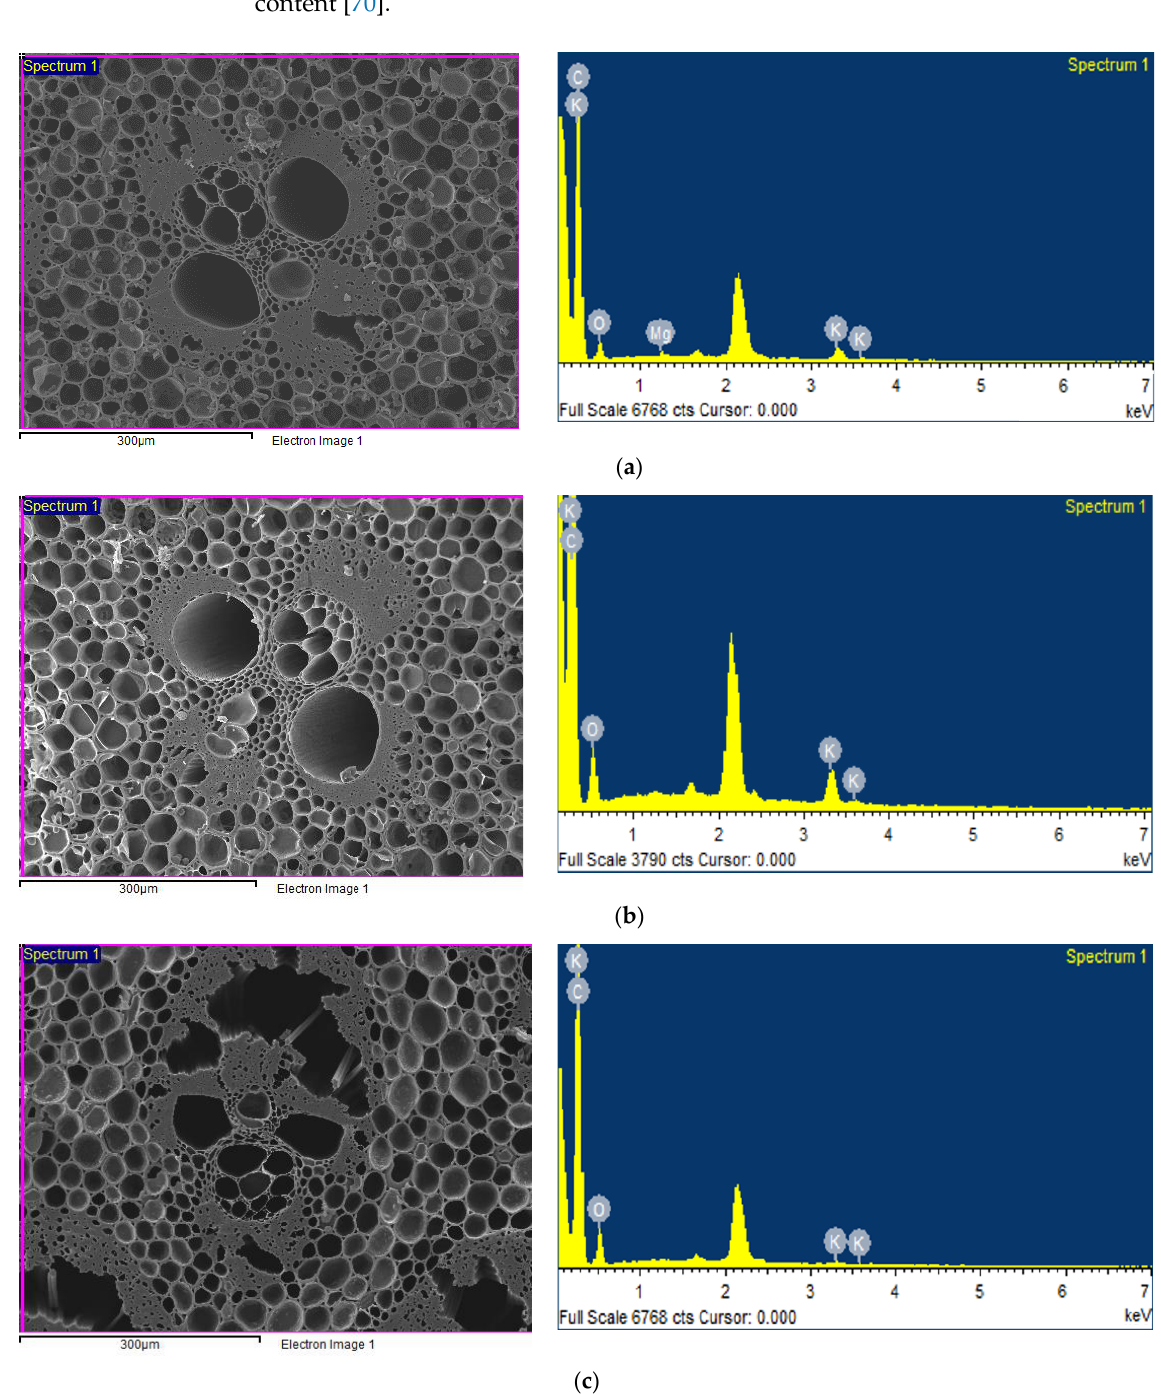
Figure 4. The pore structure of DBC biochar produced from various pyrolysis temperatures analyzed by SEM and EDS image. ( a ) DBC-400, ( b ) DBC-450, and ( c ) DBC-500. SEM analysis of the three DBC biochar products revealed that the pyrolysis temperature influenced the morphology of the biochar under an identical residence pyrolysis time and the same biomass. The significant elements found in all DBC biochar were C, O, and K, except for Mg, which was presented in DBC-400 with 0.49% wt and 0.26% atomic. The C element was the highest in DBC-500 with 81.60% wt and 85.91% atomic, followed by DBC-450 with 78.57% wt and 84.15% atomic, and DBC-400 with 78.44% wt and 84.39%